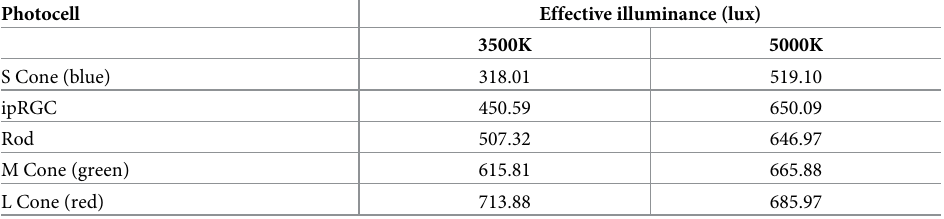
Table 1. Effective illuminance perceived by photocells for each lighting condition, taken facing the light